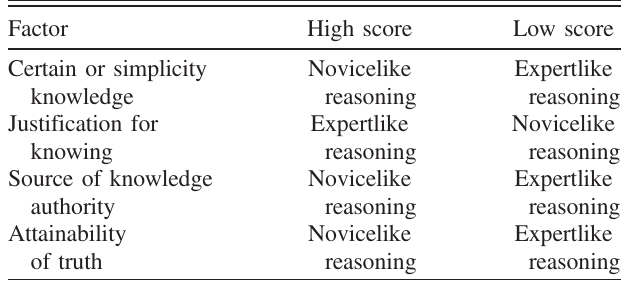
thinking in each